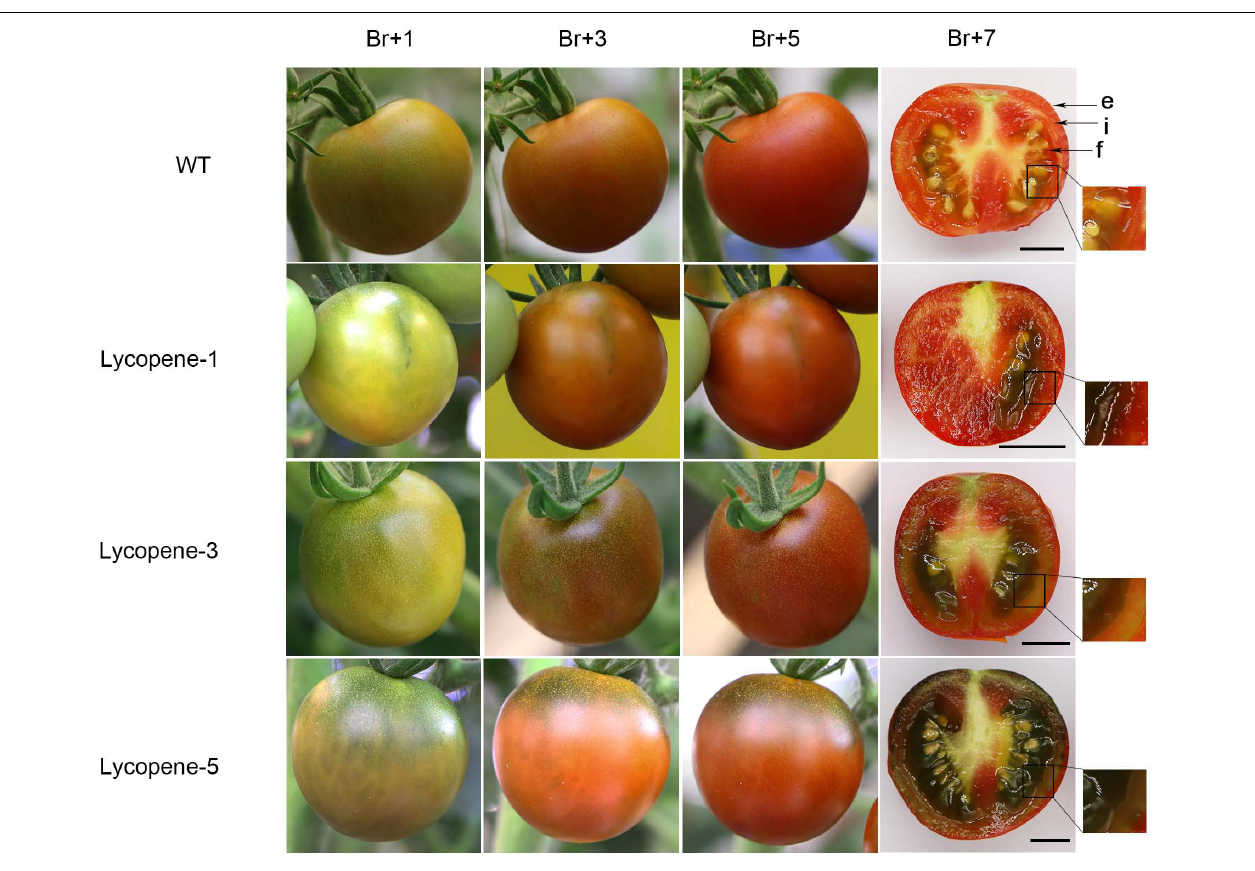
FIGURE 5 | Phenotype of tomato fruit at different ripening stages. Three groups of transgenic tomato fruits were photographed at different times after the breaker stage of ripening and compared with that in WT. Sections were obtained at Br+7. Each group photograph was obtained from the same tomato fruit. e, exocarp; i, endocarp and f, flesh of the tomato